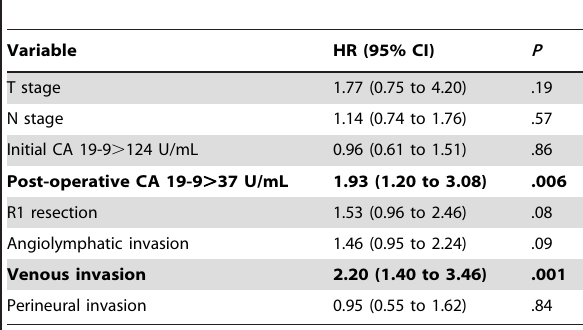
Table 3. Prognostic factors affecting disease-free survival in R0 and R1 resection by multivariate